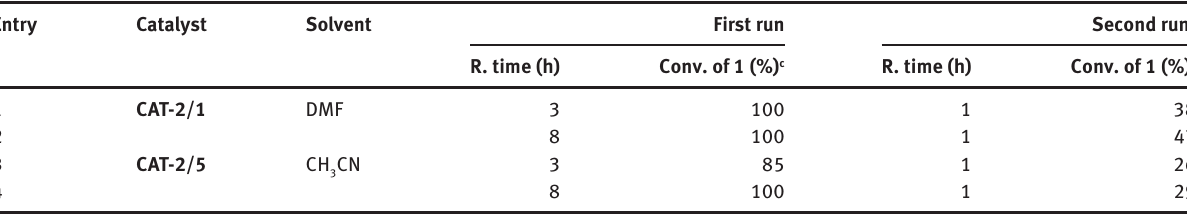
Table 3: Recirculation tests a .